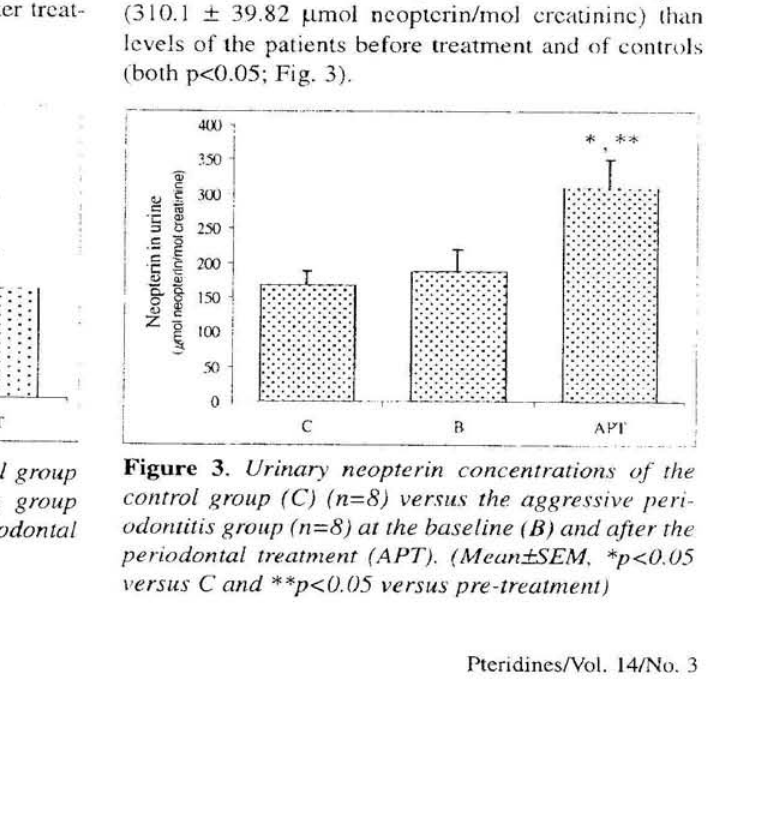
Pteridines/Vol. 14/No.